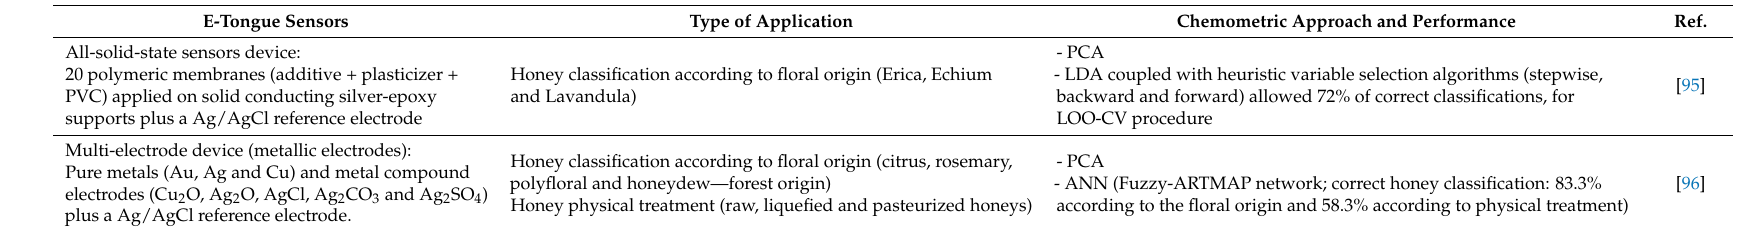
Table 2. Honey evaluation using lab-made potentiometric E-tongue based